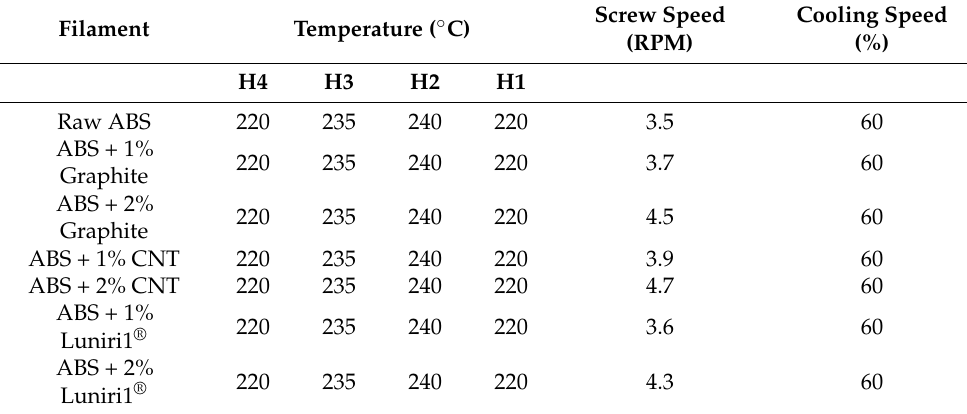
Table 4. Processing parameters during ABS filament extrusion.